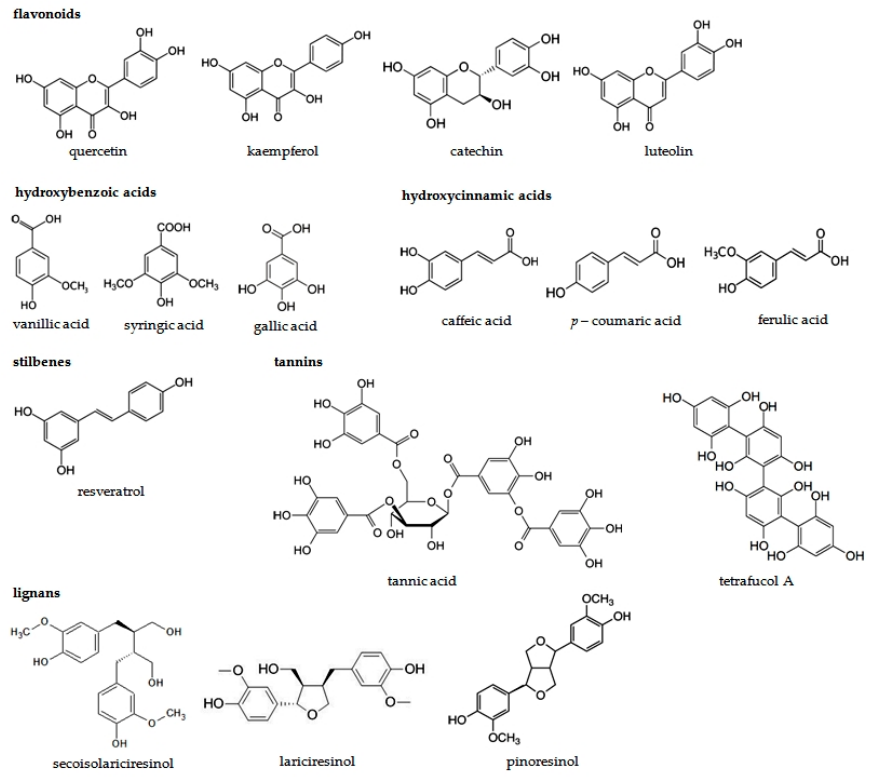
Figure 2. The examples of molecular structures of the most common phenolic